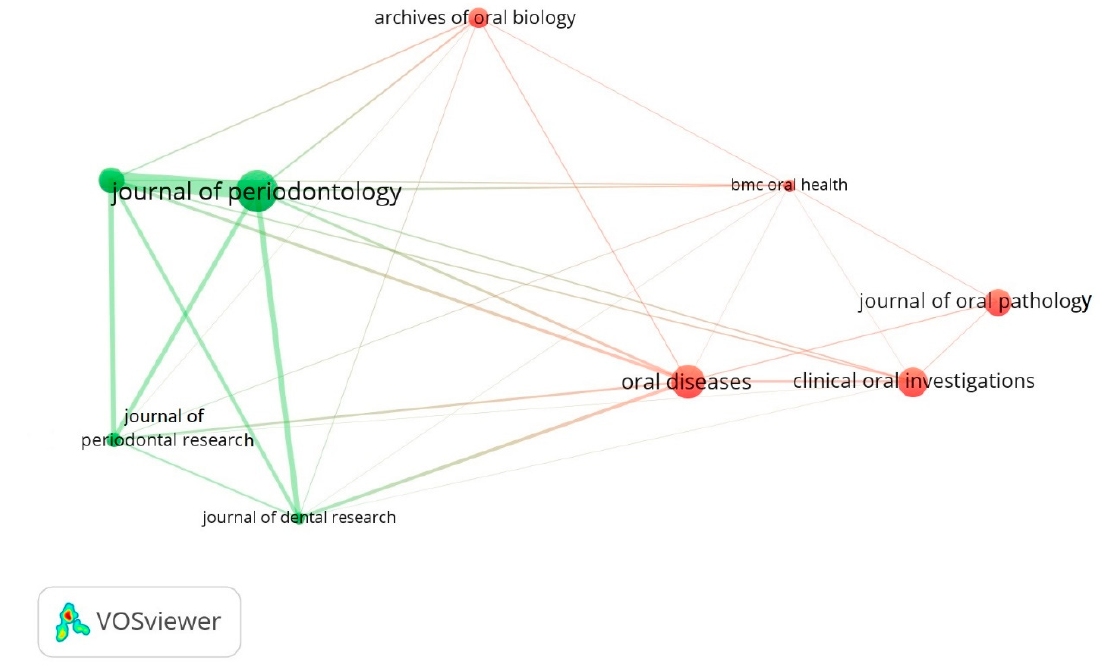
Figure 4. Showing leading journals that have published articles related to salivary biomarkers. Table 3. Displaying leading institutes that published the most within the field of salivary biomarkers.